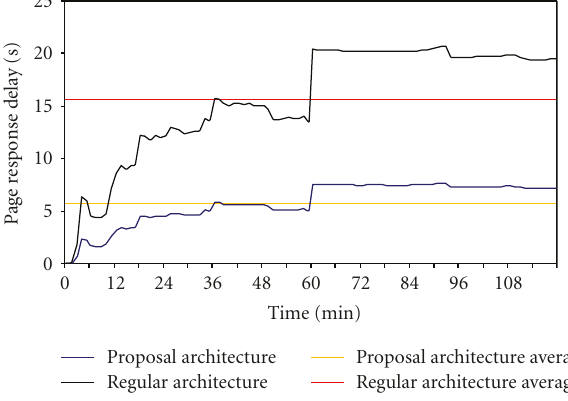
Figure 14: Request and delivery delays.